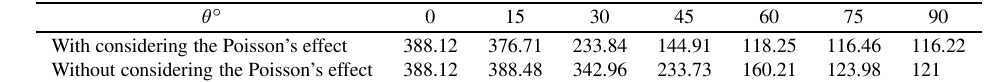
Table 2 Critical velocity (m/sec) of angle-ply beams with and without considering the Poisson’s